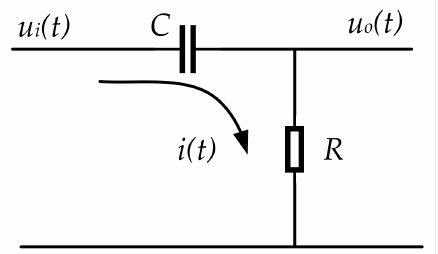
Figure 10. Schematic diagram of the first-order RC high-pass filter